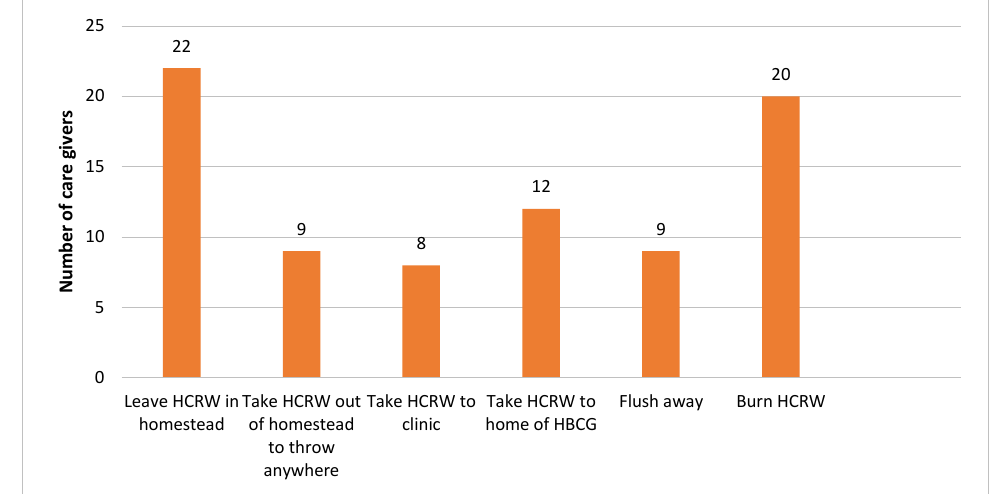
Figure 2. Methods of disposal of health care risk waste used by caregivers.